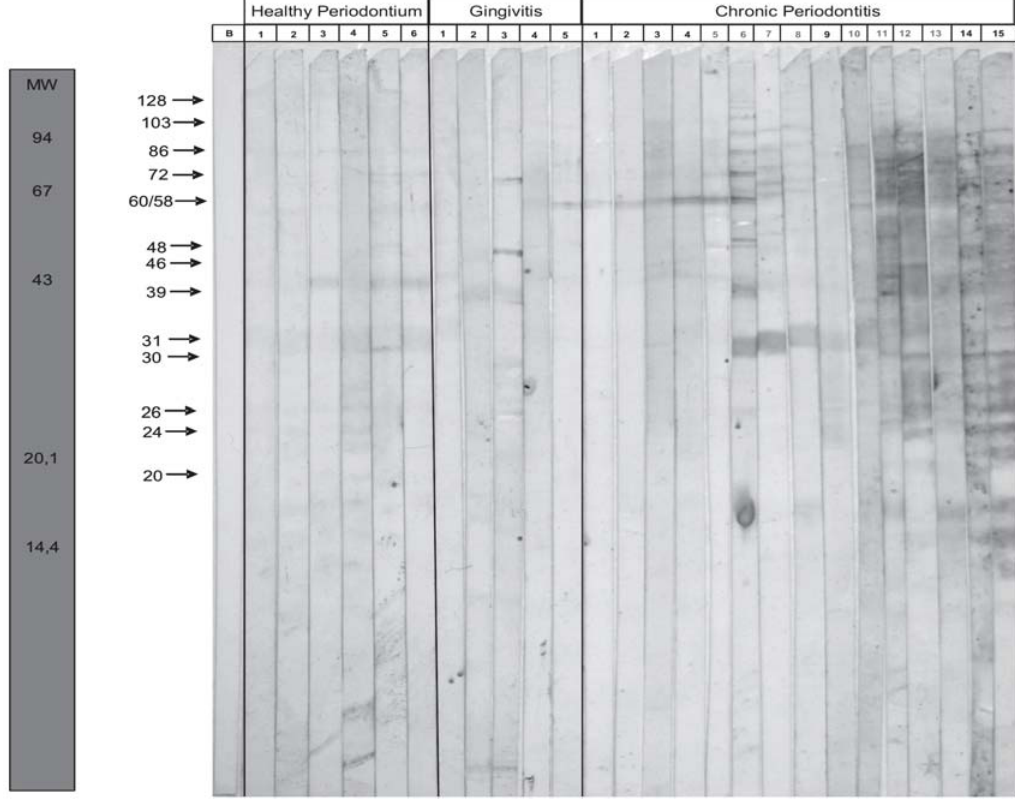
FIGURE 4- Western immunoblotting of serum sample from 15 patients with chronic periodontitis, 5 patients with gingivitis and 6 periodontally healthy individuals